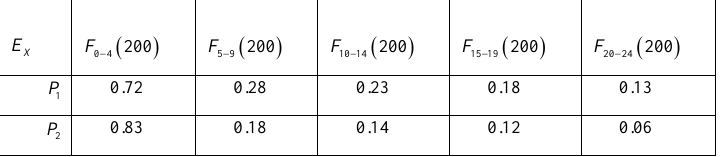
Table 4 Table of experimental results of completeness distance index for E X model and P 1 model